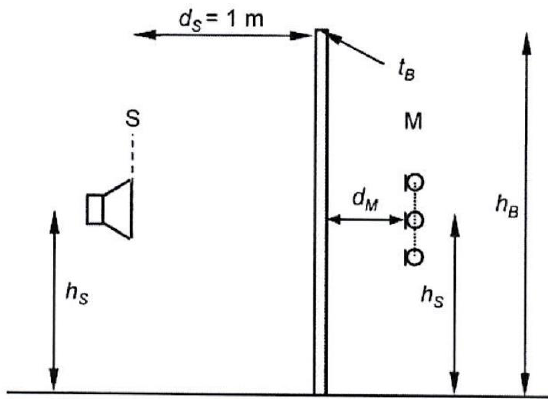
Figure 2. Diagram of the set-up for measurement of the sound insulation index [29].